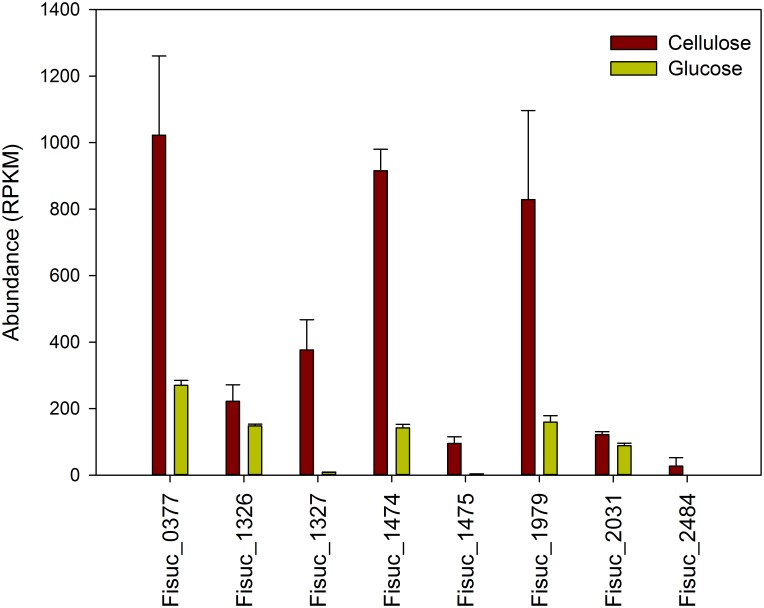
Expression of fibro-slime genes in F. succinogenes S85 cellulose and glucose cultures.The cellulose cultures showed an increased expression for 8 out of 10 fibro-slime proteins relative to the glucose cultures. RPKM = Reads Per Kilobase per Million mapped reads.